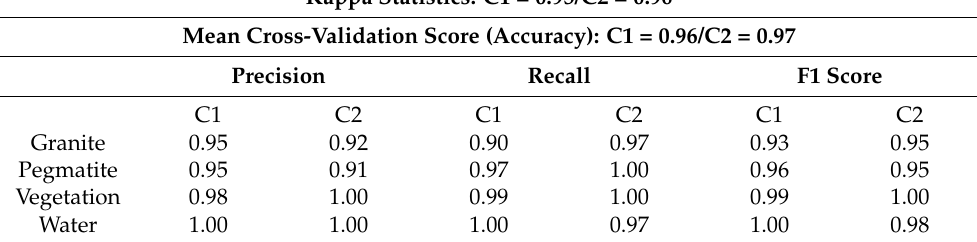
Table 4. Scores for RF model.